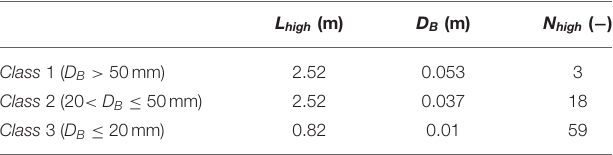
TABLE 1 | Initial parameters of the branches of tree S for the tree